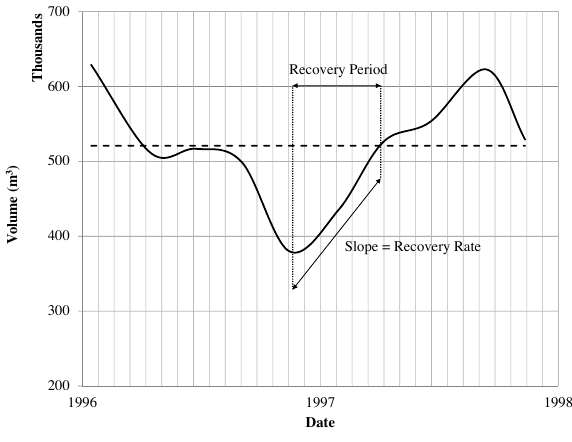
Fig. 3. Illustration of the recovery period and recovery rate of beach volume.